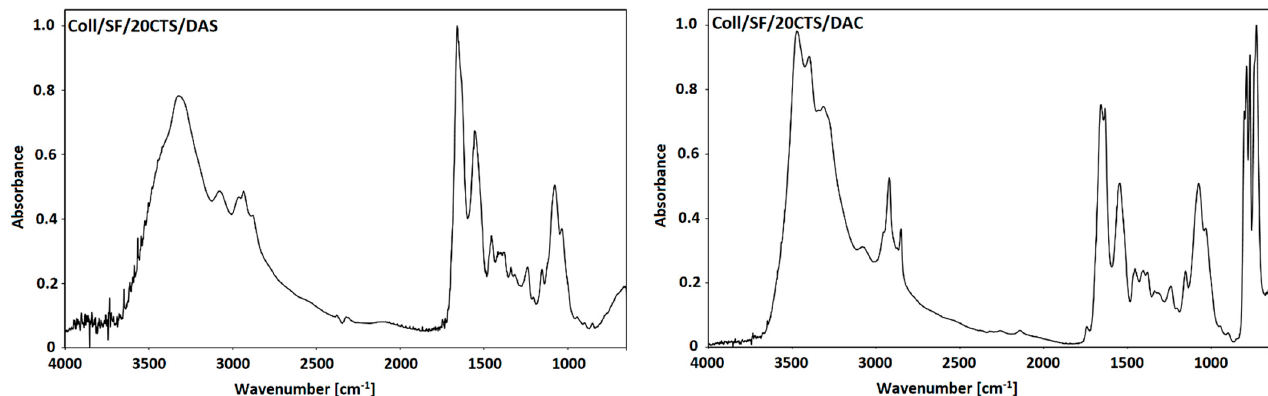
Figure 4. FTIR-ATR spectra of Coll/SF/20CTS scaffold cross-linked by dialdehyde starch (Coll/SF/20CTS/DAS) and dialdehyde chitosan (Coll/SF/20CTS/DAC). Table 2. The positions of characteristic bands for scaffolds crosslinked by dialdehyde starch and dialdehyde chitosan. Sample